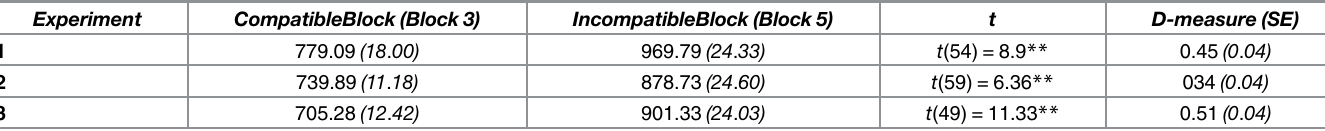
Threat/security implicit association test (threat-IAT). The mean D -measure revealed a medium effect ( M = 0.45, SE = 0.42; see Table 2 for details) of Black people being more associ- ated with threat, whereas White people are more associated with security. Pearson correlations on the D -measures of individual subjects and their mimicry effect revealed no significant corre- lations (all r - values (cid:1) 0.11; all p-values (cid:3) 0.42). Also there were no further significant correla- tions between the individual D -measure of participants and the differences of specific comparisons between reaction times when angry out-group versus in-group stimuli were Table 2. Scores on the Implicit Association Task across all three